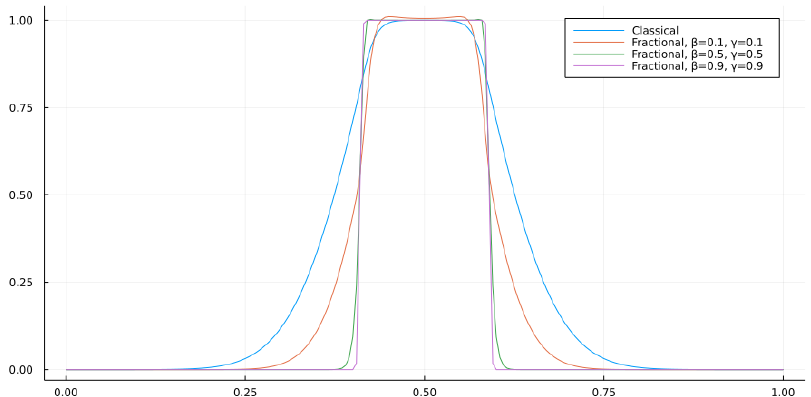
Figure 4. The result of comparison of the classical model of fluid flow in porous media with the fractional model (8) for various orders of the fractional derivatives at ¯ t =